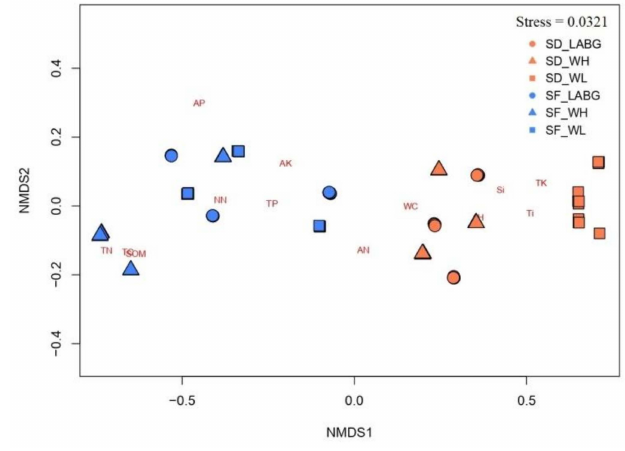
Figure 2. Non-metric multidimensional scaling (NMDS) ordination plot of physical and chemical properties of soil samples collected near flowering individuals of S . digitaloides and S . flava . Circle, triangle, and square symbols with coral color denoted Lijiang Alpine Botanical Garden (LABG), Wenhai Village (WV), and Wenhai Lake (WL) study sites of S . digitaloides . Circle, triangle, and square symbols with blue color denoted LABG, WV, and WL study sites of S . flava . The measured soil properties were soil water content (WC), pH, soil organic matter (SOM), total nitrogen (TN), nitrate-nitrogen (NN), ammonium nitrogen (AN), total phosphorus (TP), available phosphorus (AP), total potassium (TK), available potassium (AK), silicon (Si), total carbon (TC), and titanium (Ti). Permutational multivariate analysis of variance (PERMANOVA) was used to compare soil properties between the two species at different sites. Table 1. Soil properties on the different study sites where S . digitaloides and S . flava